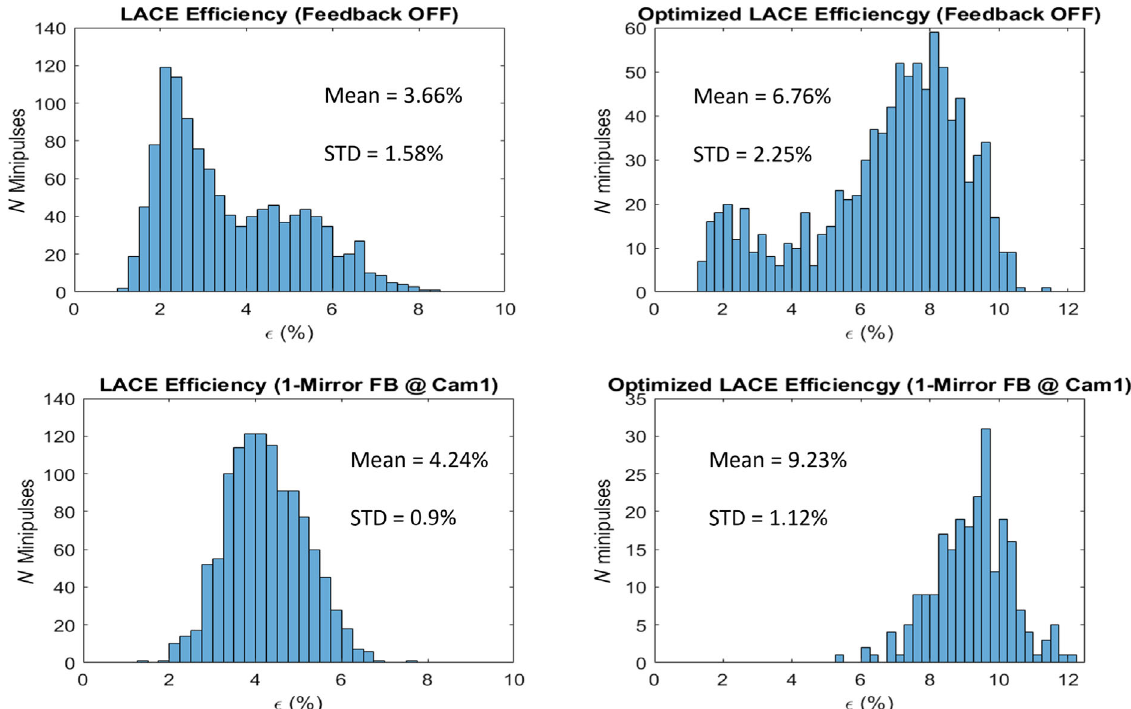
FIG. 13. A histogram of the stripping efficiency in the sequential excitation experiment for different conditions of the laser positioning feedback. Top left: The feedback is off. Top right: The feedback is off, but the laser beams are aligned. Bottom left: The feedback is on, but the laser beams are not well aligned. Bottom right: The feedback is on, and the laser beams are optimally